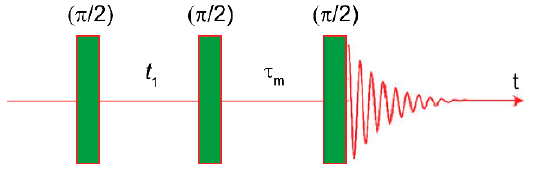
Figure 2. Pulse sequence for the NOE experiment (basic version).